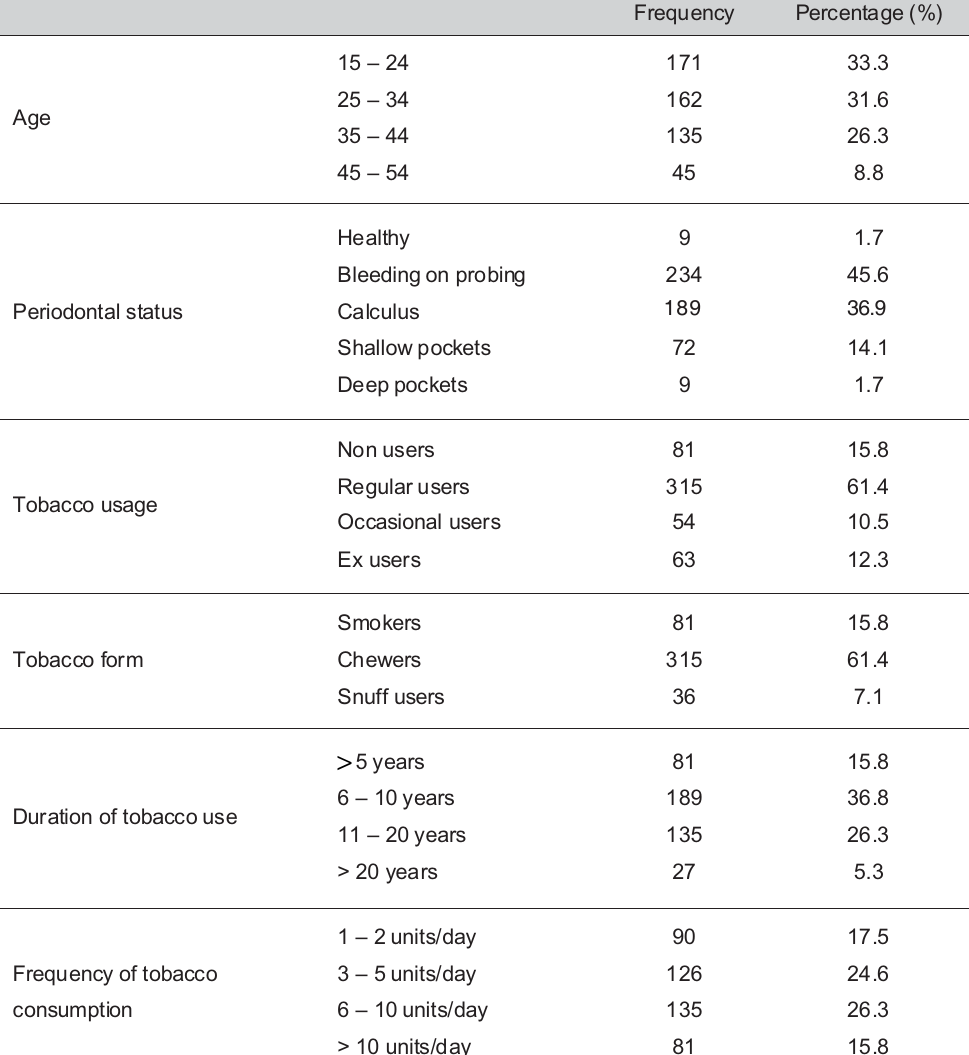
Table 1- Background and general sample